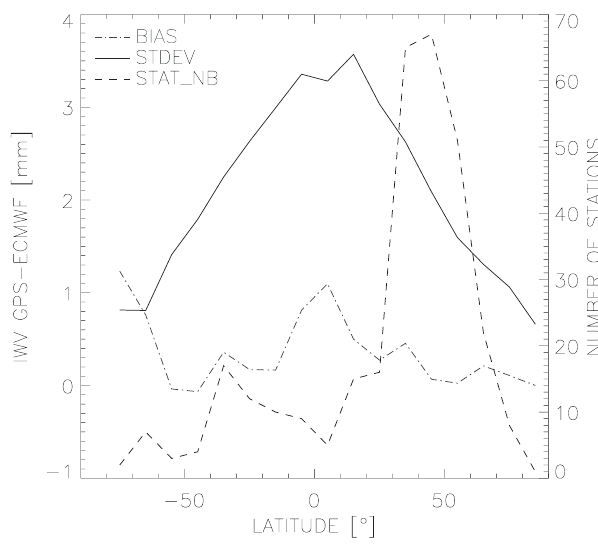
Fig. 5. Latitudinal dependence of IGS station number (dashed line), zonal mean bias (dash dot line) and standard deviation (solid line) between GPS and ECMWF IWV corresponding to Fig. 4. Zonal means and station number refer to 10 ◦ latitude